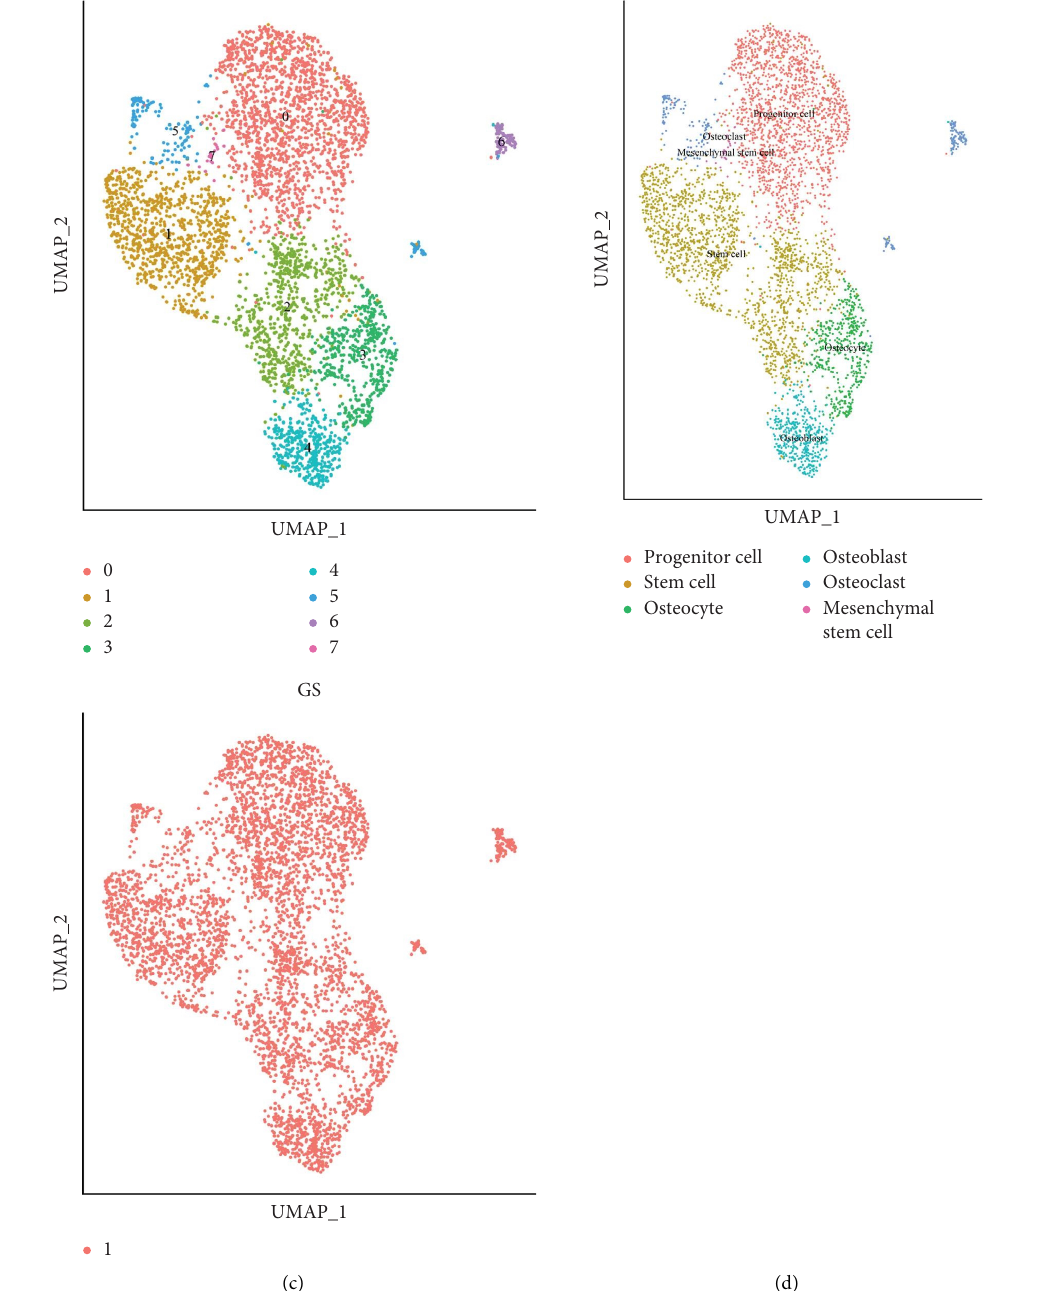
Figure 4: (a) Te ElbowPlot function was used to evaluate PC. (b) Visualization results of the JackStrawPlot function for comparing the distribution of P values for each PC to the uniform distribution (dashed line). Signifcant PCs are shown above the dashed line with a signifcant P value. (c) Cluster results by UMAP method. (d) Proportional distribution of cells in the